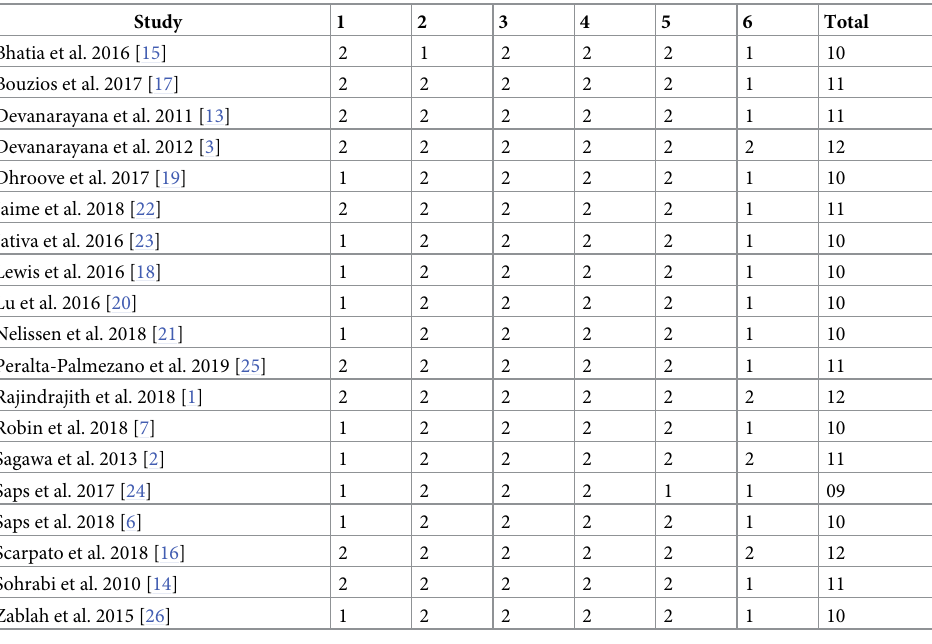
Table 2. Quality assessment of studies.